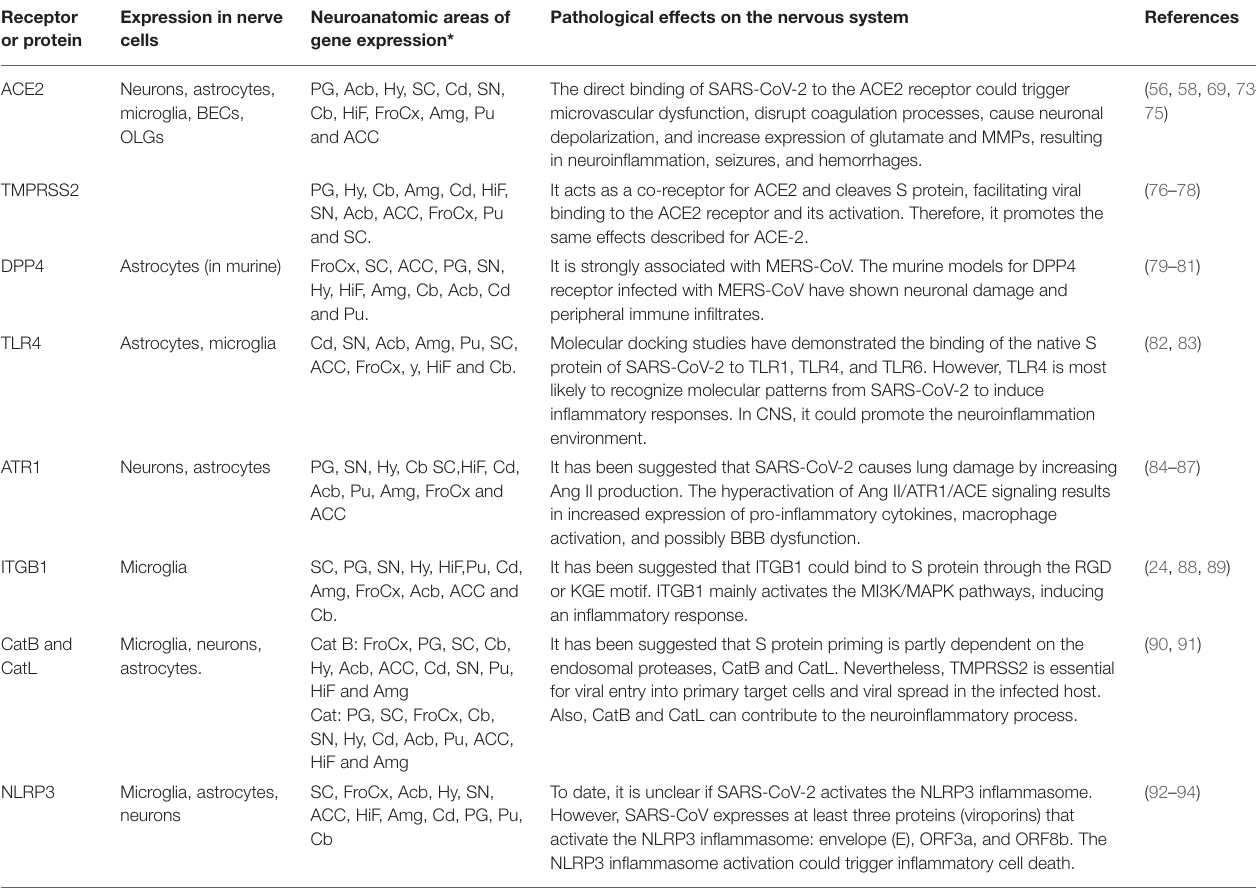
TABLE 1 | Receptors or proteins related to SARS-CoV-2 infection in the nervous system. Receptor or